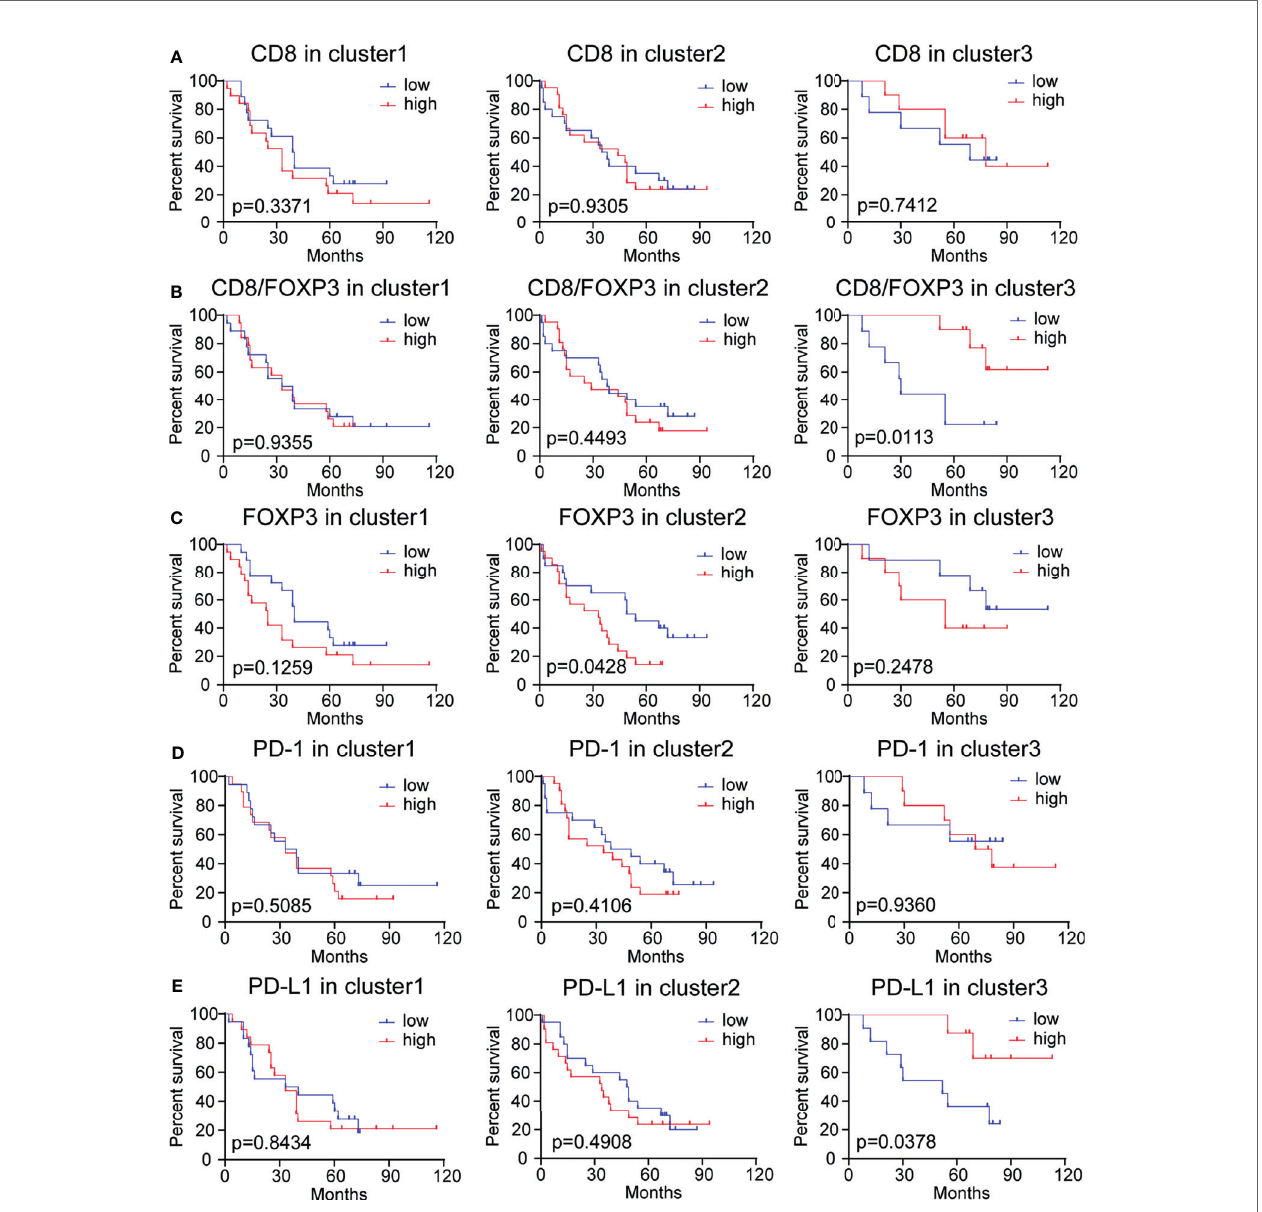
FIGURE 5 | Kaplan – Meier analysis of the overall survival rate (OS) in subgroups of patients strati fi ed based on CD8, CD8/FOXP3, FOXP3, PD-1, and PD-L1 expression levels. (A) Survival results for 97 NSCLC patients with different CD8+ cell densities. These patients were sorted into 3 clusters generated based on the CD8/FOXP3 ratio and PD-1 and PD-L1 expression levels. Patients with high or low CD8 expression had no signi fi cant difference in OS (p >0.05). (B) Survival results for 97 NSCLC patients with different CD8/FOXP3 ratios. The survival rate of patients with higher CD8/FOXP3 expression in cluster 3 was signi fi cantly increased (p <0.05). (C) Survival results for 97 NSCLC patients with different FOXP3 expression levels. Patients with higher FOXP3 expression in cluster 3 had poor survival (p <0.05). (D) Survival results for patients with different PD-1 expression levels: no difference was observed (p>0.05). (E) Survival outcome for 97 NSCLC patients with different PD-L1 expression levels. The survival rate of patients with a high PD-L1 expression level in cluster 3 was signi fi cantly increased (p<0.05). The median cutoff value was used to distinguish high density from low density. A log-rank test was used to perform statistical